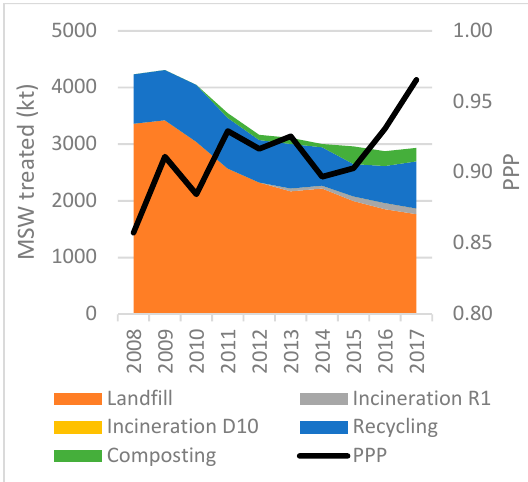
Figure 4. Waste treatment methods and PPP in Bulgaria 2008–2017 (EUROSTAT 2019b, 2019c).